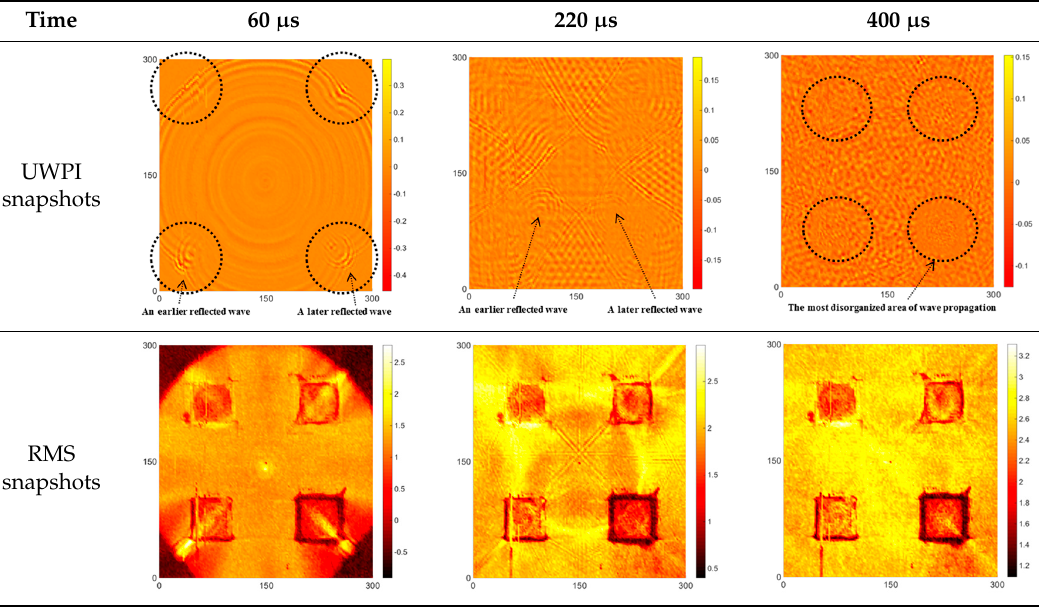
Table 4. UWPI and RMS snapshots of the front side of Specimen 1 at 60 μ s, 220 μ s and 400 μ s (the unit of x and y axis: mm).